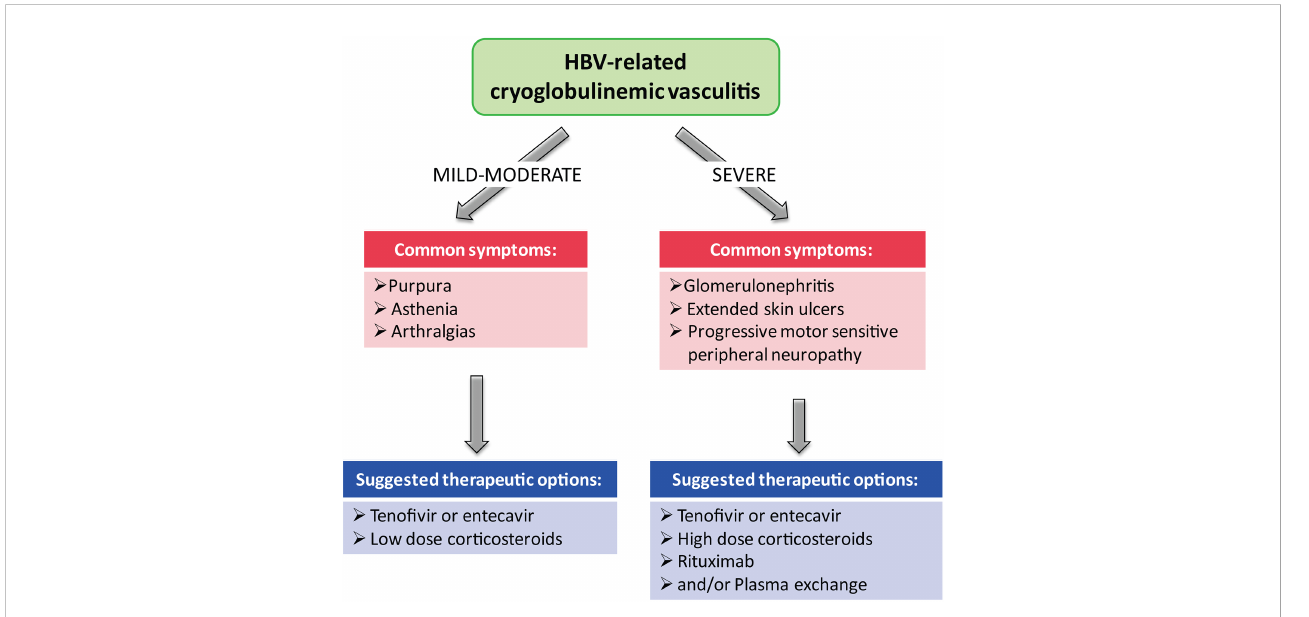
FIGURE 1 Therapeutic strategies in HBV-related cryoglobulinemic